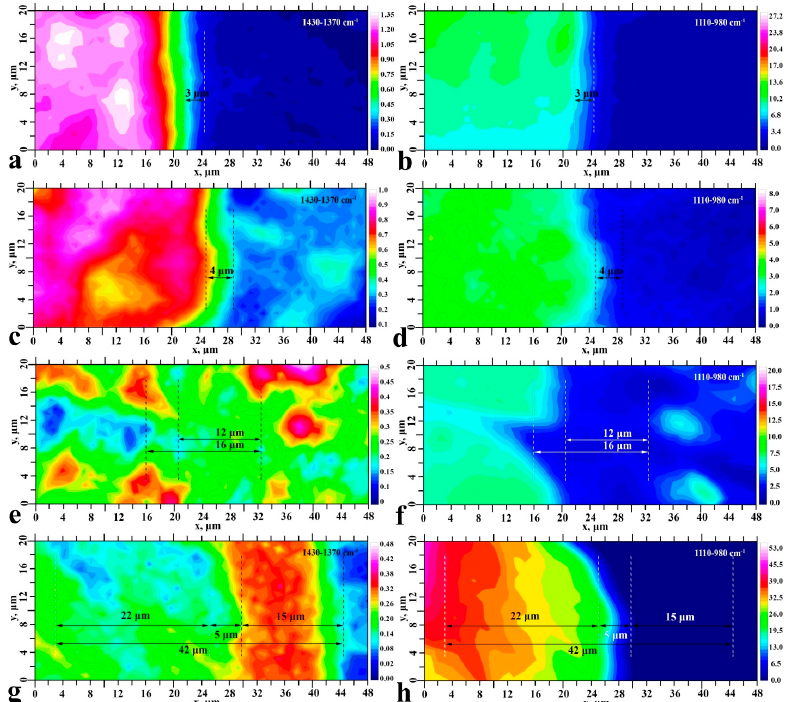
Figure 5. Chemical images of typical surface areas reflecting the spatial distribution in the interface region (see Figure 1) of the CH and COO- group vibrations ( a , c , e , g ) and phosphate vibrations ( b , d , f , h ). Sample S I —( a , b ); sample S II —( c , d ); sample S III —( e , f ); sample S IV —( g , h ).